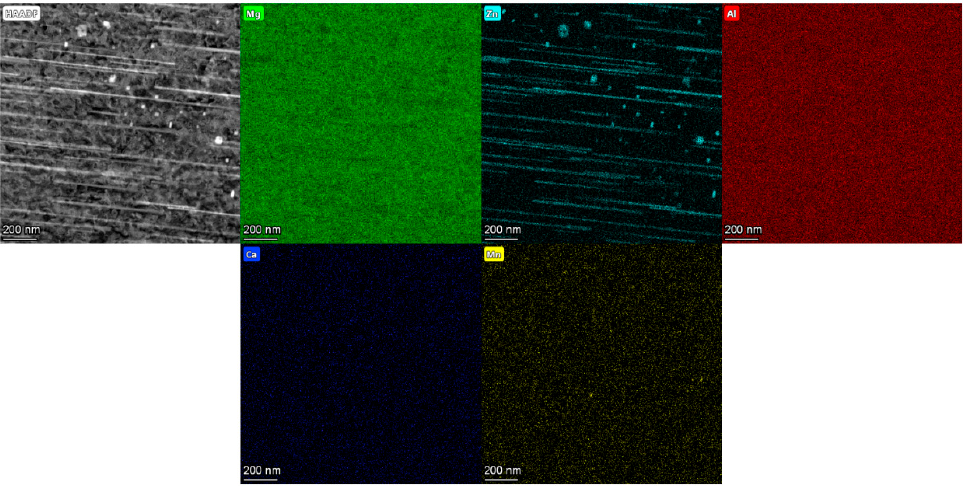
Figure 9. HAADF image of peak-aged ZAXM4100 alloy sheet corresponding to the Figure 8c and EDS mapping results for Mg, Zn, Al, Ca and Mn.